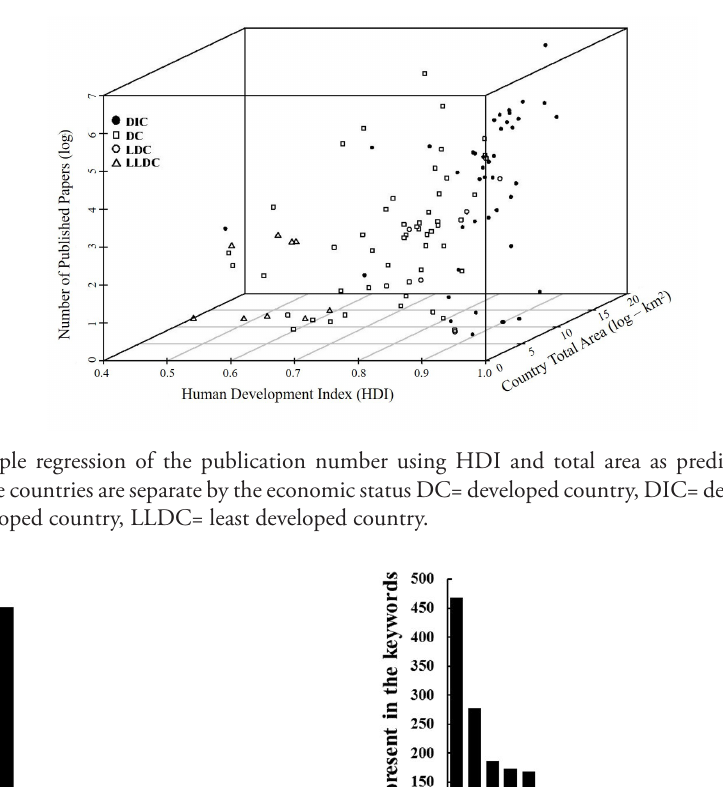
Figure 7. (a) Environments that appeared most often in the keywords. (b) Taxonomic groups that appeared most